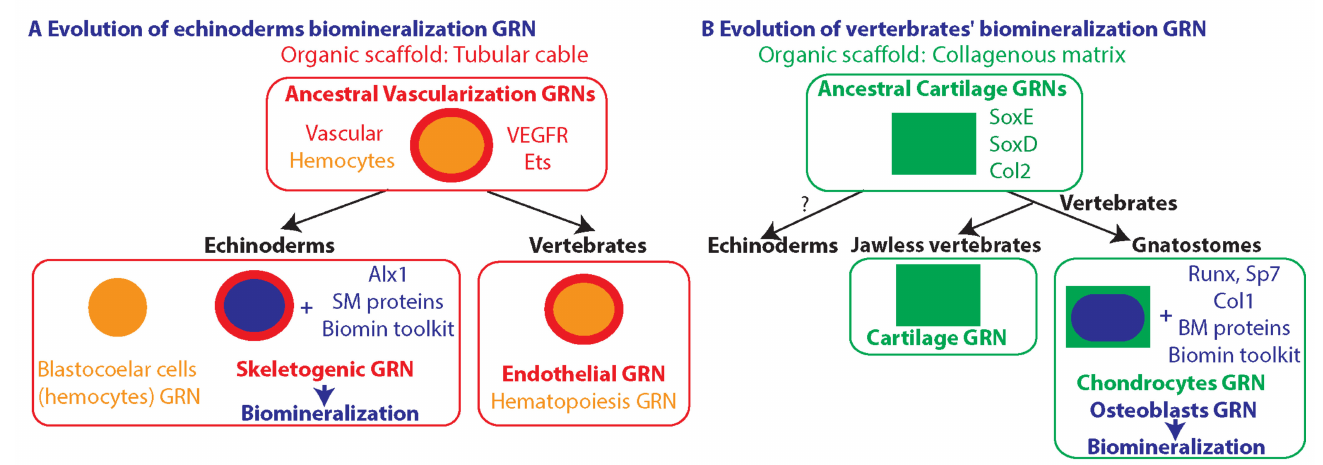
Figure 5. Proposed models of the evolution of the biomineralization GRNs in echinoderms and in vertebrates. ( A ), an ancestral vascular GRN that generated blood vessels where hemocytes flow evolved in vertebrates to make the endothelial GRN and was co-opted for biomineralization in echinoderms. The ancestral vascular GRN included the VEGF pathway and transcription factors of the ETS family. Co-option for biomineralization included the activation of the transcription factor Alx1, the evolution of novel echinoderm spicule matrix (SM) proteins and the activation of genes of the biomineralization toolkit. The vertebrate endothelial GRN and the echinoderm skeletogenic GRN show similarities and trans-differentiation potential to the hemocyte GRN. ( B ), an ancestral GRN that drove cartilage formation was co-opted for biomineralization in the vertebrate phylum. The ancestral cartilage GRN included the transcription factors SoxE and SoxD that drove the expression of Col2. The co-option for biomineralization was through the activation of the transcription factors Runx and Sp7, the evolution of novel bone matrix (BM) proteins and the activation of Col1 and genes of the biomineralization